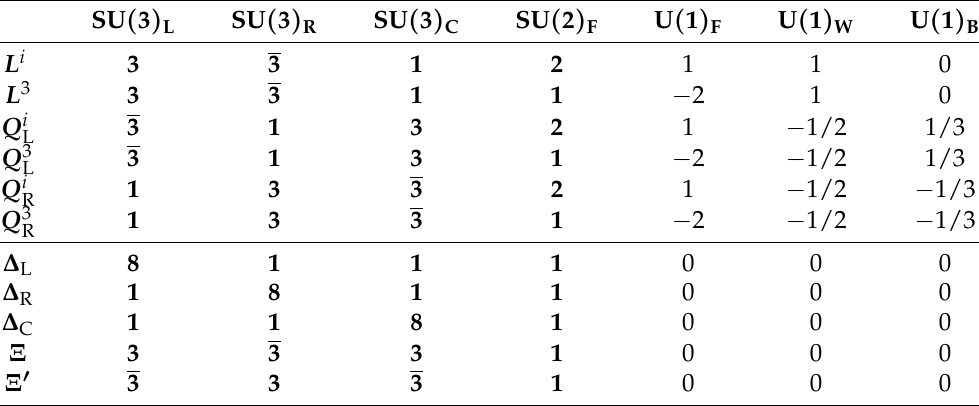
Table 2. Upper part: fundamental chiral superfields in the [ SU ( 3 )] 3 × SU ( 2 ) F × U ( 1 ) F theory– components of the massless ψ µ i and ψ µ 3 superfields of E 6 × SU ( 2 ) F × U ( 1 ) F [42]. Lower part: the corresponding components of the massive superfield ( 78 , 1 ) 0 . Accidental symmetries’ charges are shown in last two